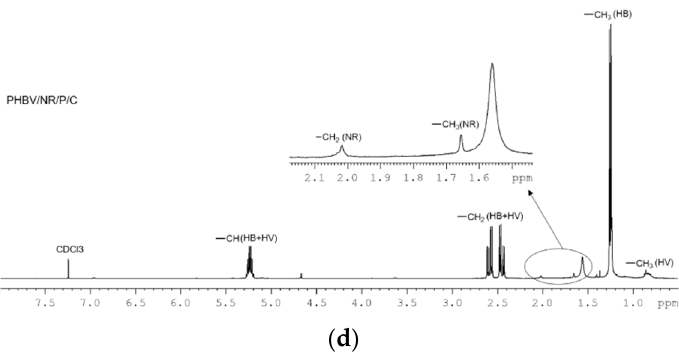
Figure 10. 1 H NMR spectra of ( a ) PHBV, ( b ) NR, ( c ) the chloroform-soluble part of PHBV/NR/P, and ( d ) the chloroform-soluble part of PHBV/NR/P/C.